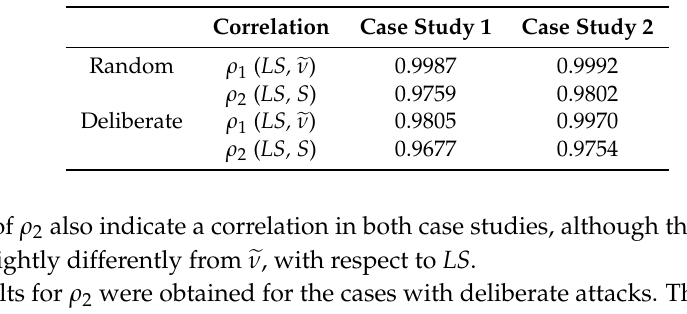
Table 1. Correlation between power flow index ( LS ) and graph theory indexes ( (cid:101) ν , S